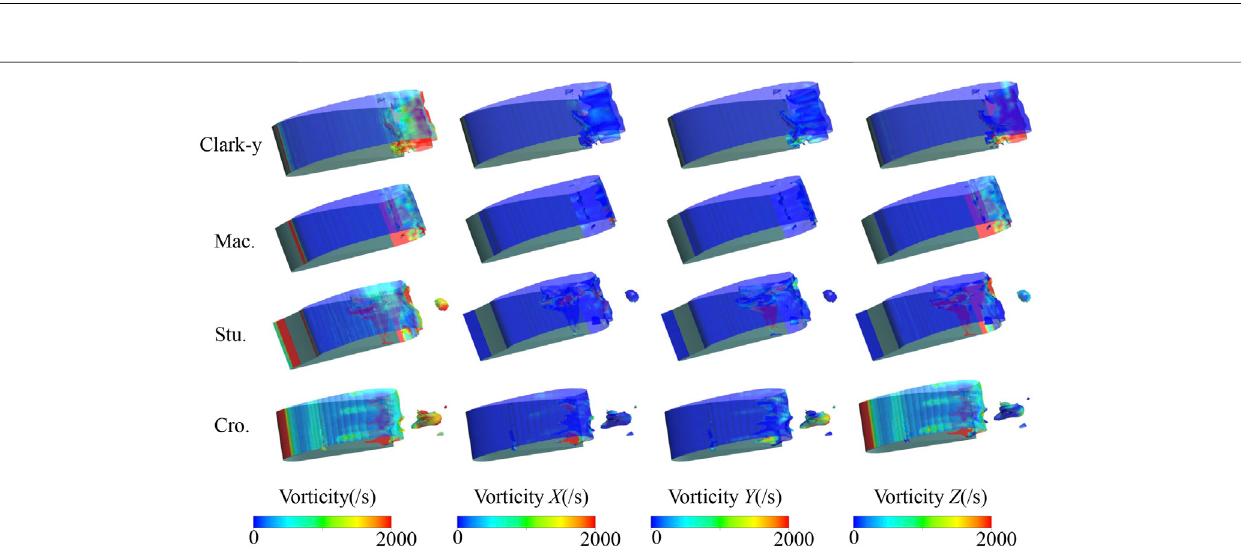
FIGURE 10 | Distribution of total vorticity, vorticity X, vorticity Y and vorticity Z of the four hydrofoils at the same time ( t (cid:1) 60 ms).